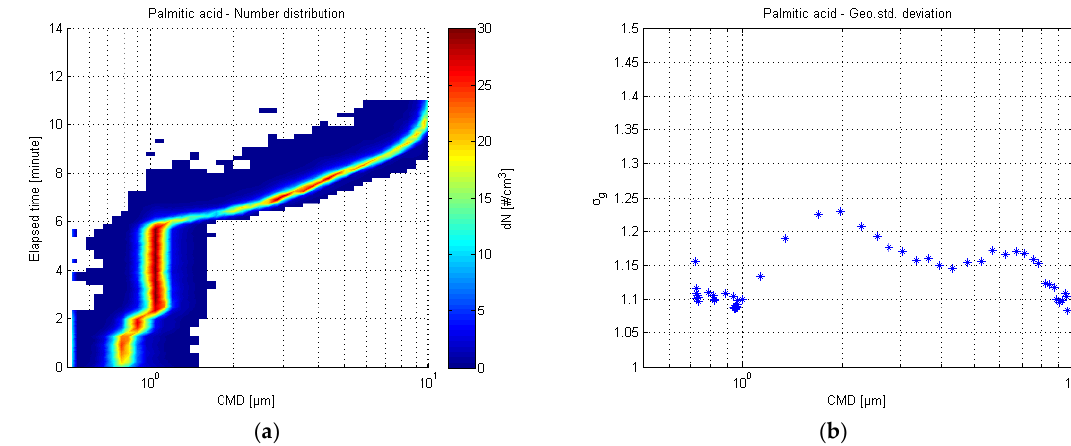
Figure 5. APS number distribution of the palmitic acid test ( a ) and the respective geometric standard deviation plot ( b ).